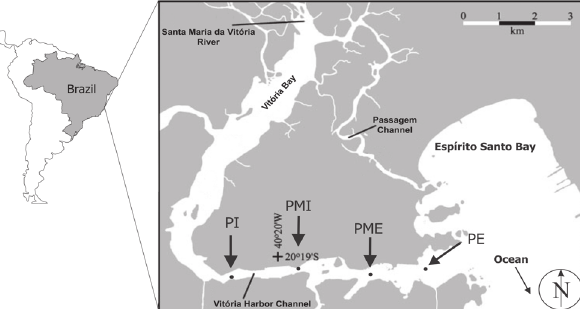
Figure 1. Location of the Vitória Bay and the four study stations along the Vitória Harbor channel: (PI) Internal Station, (PMI) Inter- nal Midpoint (SME), External Midpoint and (EP) External